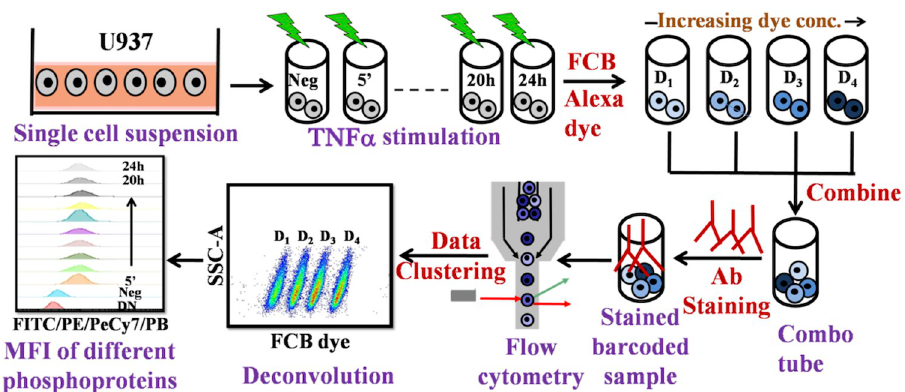
Fig 9. Schematic of high throughput signaling experimentation. Cells are harvested and incubated with inhibitor or stimulus for the desired time. After incubation, cells are fixed using paraformaldehyde and subsequently permeabilized with methanol. Four samples, each containing sufficient number of cells, are then incubated with amine-reactive fluorescent barcoding (FCB) [55,56] dye with different concentrations. These four samples are combined in a combo tube. After covalent binding, cells in the combo tube are washed several times to remove unbound dye, following which they are exposed to monoclonal antibody against the intracellular proteins. Fluorescence emitted by cells in the combo tube is then acquired on a flow cytometer. After acquisition, the samples are analyzed by gating and identifying individual samples displaying discrete fluorescent intensities (D1, D2, ... D4) in the FCB channel. Mean fluorescent intensities of the fluorescence distribution corresponding to individual proteins are captured in different channels based on the fluorochrome antibody for further